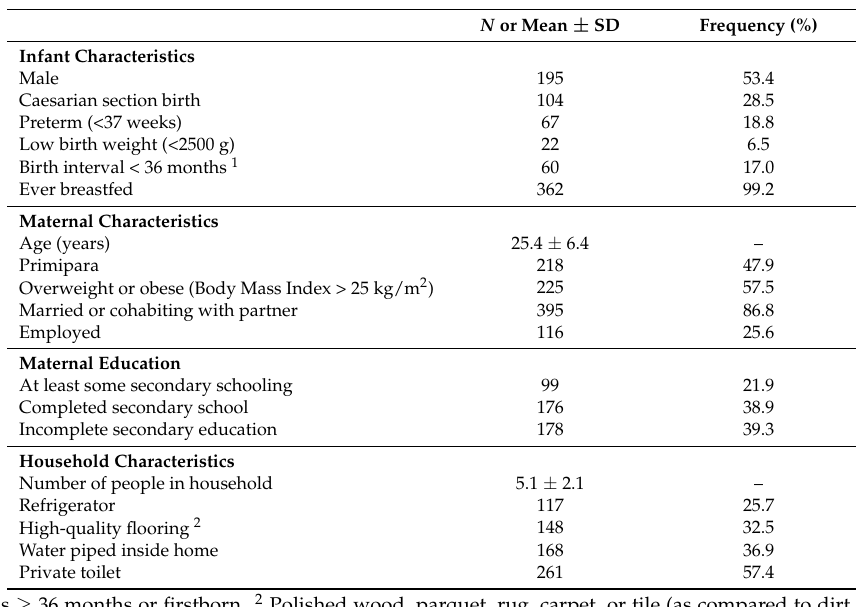
Table 1. Characteristics of the study population.